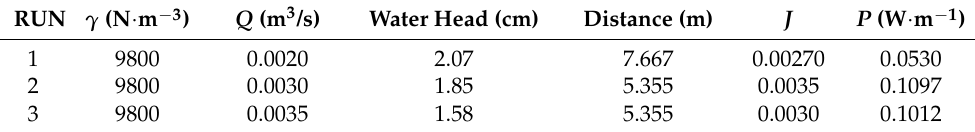
Table 4. Sinuosity and rotation angle of bend B4 upon cutoff occurrence.